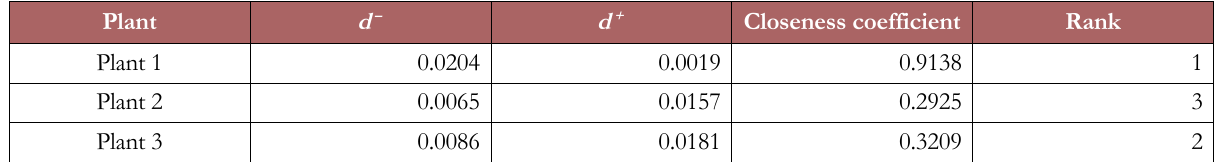
Table 20. Distance, closeness coefficient and the rank of each plant (autonomous systems)